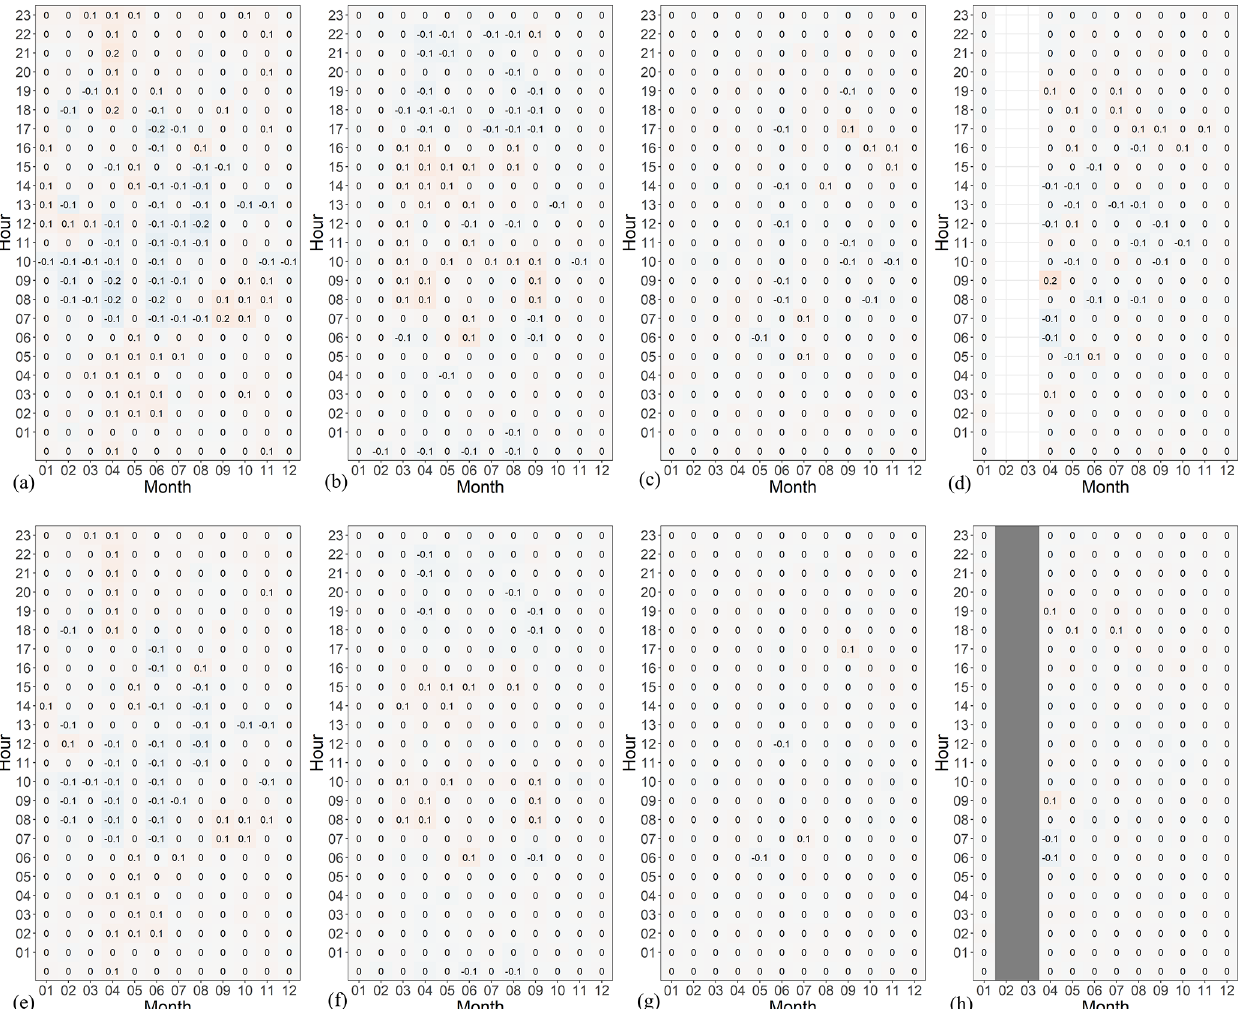
Figure D2. Same as Fig. 10 but for QC level 3. Comparison between (cid:49)T for the test dataset (a–d) and (cid:49)T for the complete dataset (e–h) .